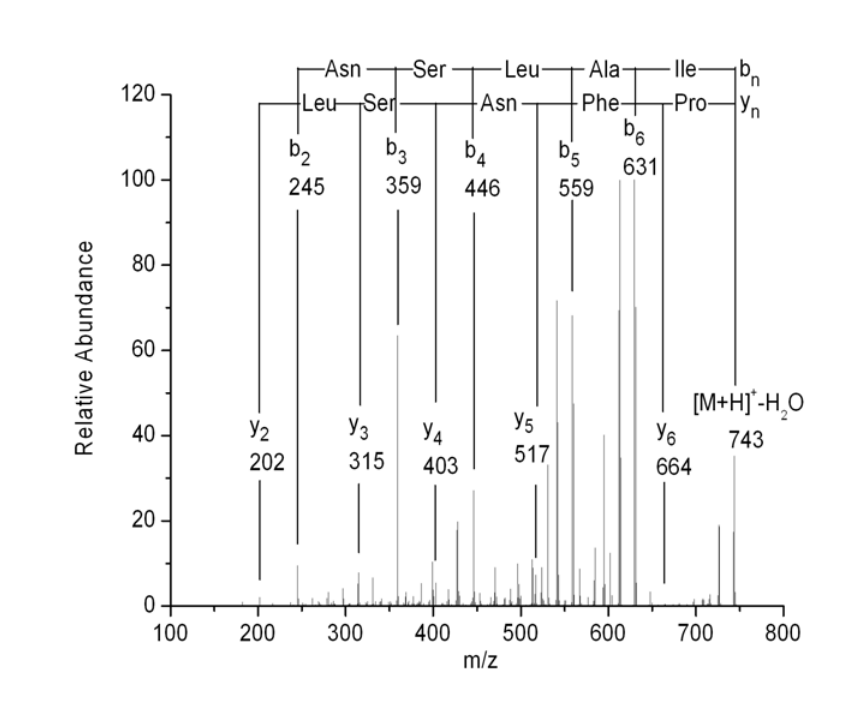
Fig. 6 CAD spectrum of crude heptapeptide 1 from [M+H] + ion of m/z 761.5. The x, z, a, and c ions were not labeled for